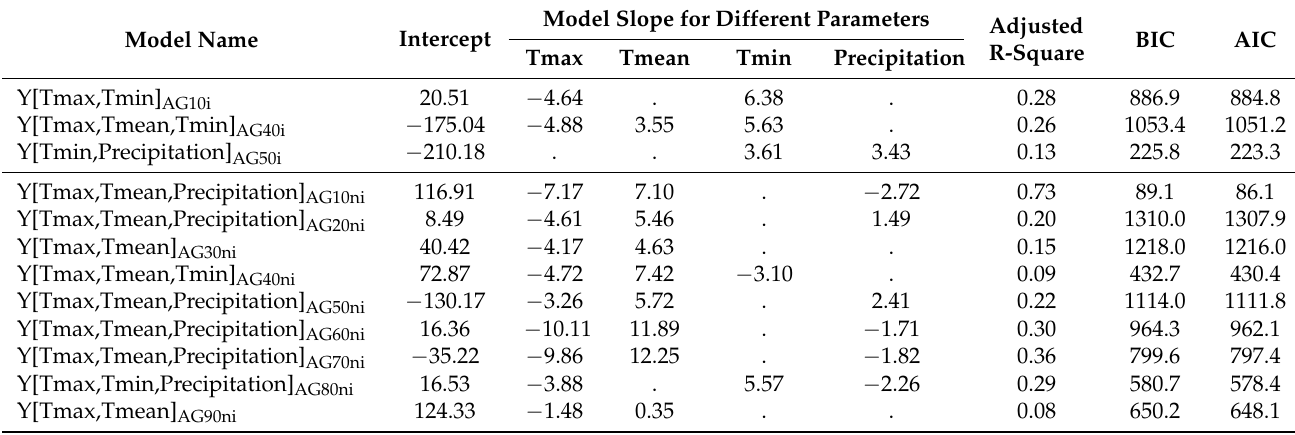
Table 2. The results of the best linear and multilinear models from the time series of 1980–2019 for irrigated and non-irrigated agricultural districts in Mississippi.